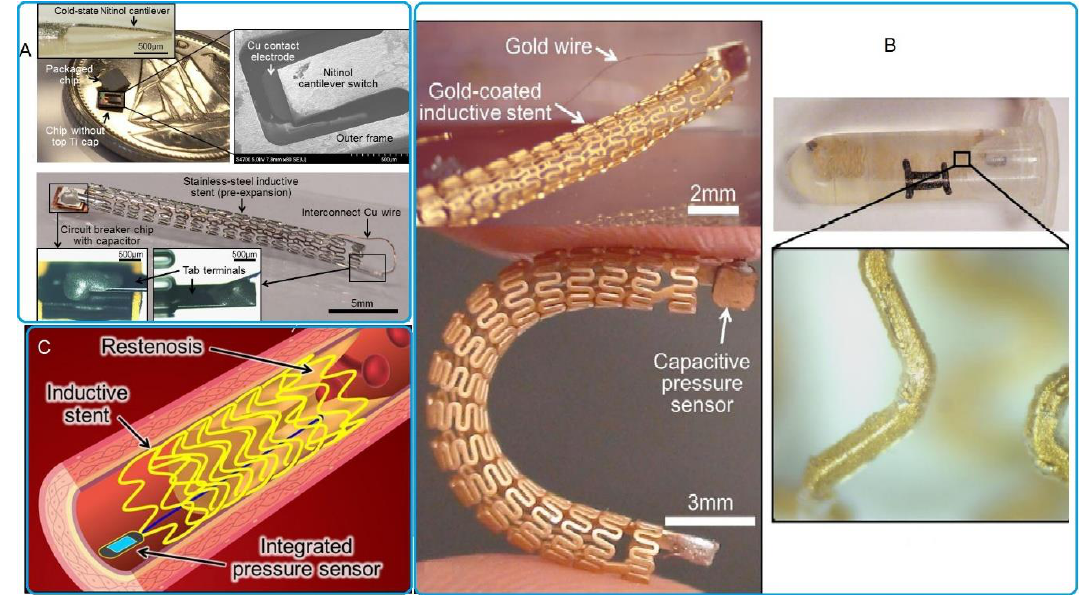
Figure 3. The pressure sensor using a stent as an antenna integrated with MEMS capacitive: ( A ) Completed active stent device with the stent terminal on which the interconnect wire was bonded. Reproduced with permission [44], copyright 2020, IEEE; ( B ) fabricated LC-tank stent devices integrated with capacitive pressure sensors and a device coated with Parylene C; ( C ) conceptual diagram of wireless sensing of vascular conditions through the sensor-integrated smart stent. Reproduced